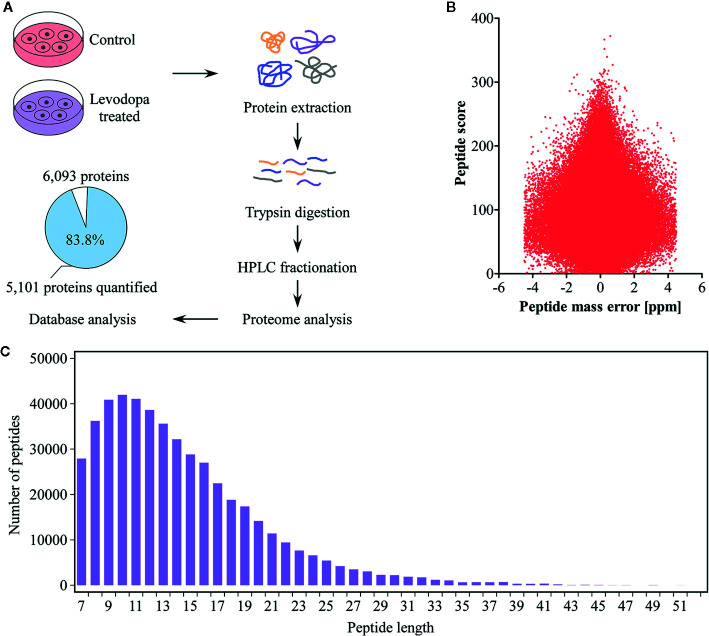
Proteomics identification of KYSE150 ESCC cells following levodopa treatment. (A) Experimental design of proteomic identification of KYSE150 ESCC cells after 24 h of levodopa treatment (0 or 600 μM). The percentage and number of proteins quantified are shown in the pie chart (Adj. P < 0.05, fold change > 1.5). (B, C) The distribution of peptide mass error (B) and peptide length (C) of protein peptides identified in this study. Values are expressed as mean ± SD (n = 3). ANOVA testing was performed.